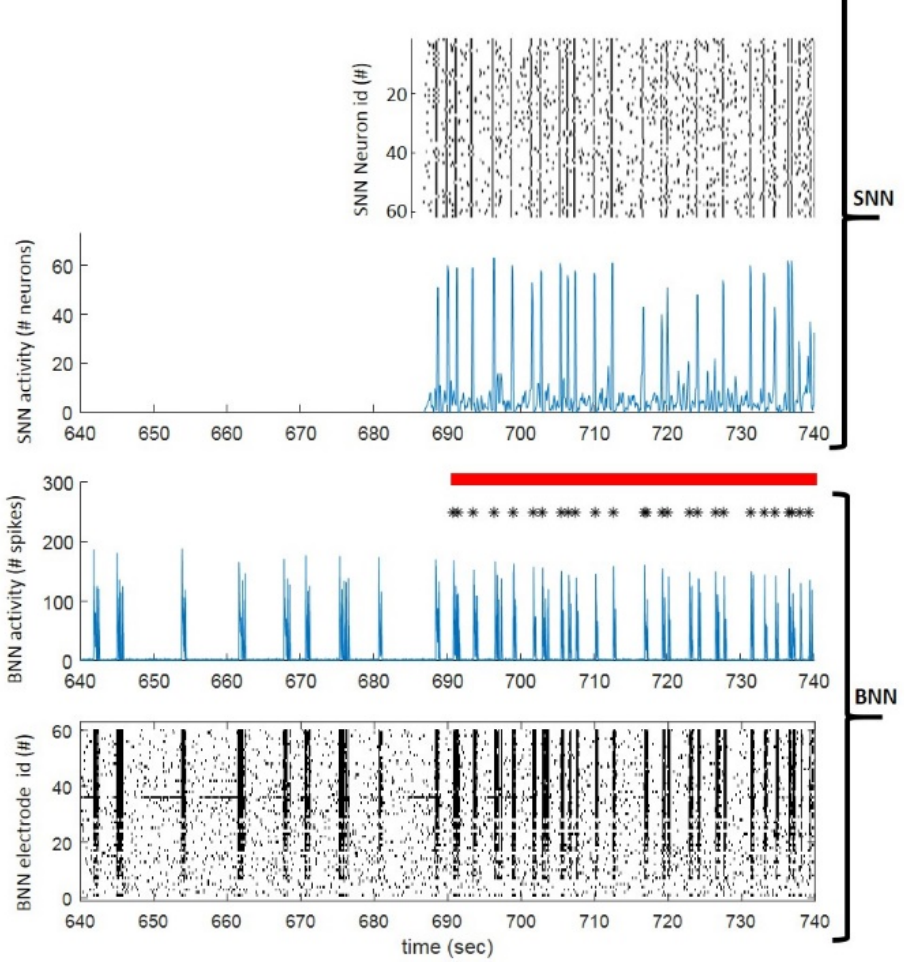
Figure 5. BNN and SNN dynamics. Focus on a few hundreds of seconds of BNN and SNN record- ings. From 690 to 749 s, (red horizontal bar) the SNN dynamic trains the BNN through stimulation (black asterisks, ‘*’). The raster plots of SNN ( top ) and BNN ( bottom ) are described in time bins of a hundred milliseconds. The total number of spikes in SNN and BNN are represented by the blue plots in the same time bins as the raster plots. We can notice a high correspondence between peaks in SNN and BNN when the communication from SNN to BNN is activated.